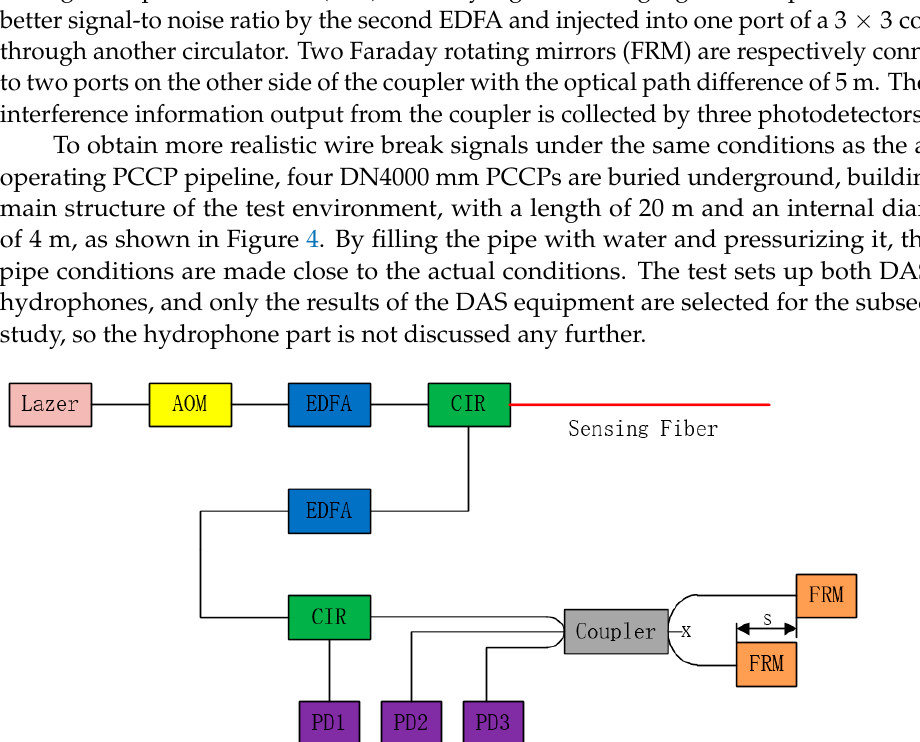
Figure 4. Sketch of the test setup. Prior to the test, seal panels are installed at both ends of the PCCP and customized cable entry seals are installed in the opening on the side walls of the manhole; a pressure- and water-resistant armored communication fiber-optic backbone cable is placed from the control room to the opening, and the armoring will attenuate the acoustic signal reaching the fiber core, thus reducing the signal-to-noise ratio. However, armoring is necessary to protect the fiber-optic cable; therefore, the armoring method must be iden- tical in all phases of the experiment to ensure that the signal can be accurately identified; then, polyurea is used to seal the gap between the fiber-optic cable and the entry device, adhering the sensing fiber-optic cable to the inner wall of the PCCP. We then splice the backbone fiber-optic cable and the acoustic fiber tail cable, splice the tail cable in the control room, and connect the DAS instrument; we close the discharge valve, seal the manhole, fill the pipe with water, and use a pressure pump to pressurize the pipe after filling it with water and keep the pressure stable. An electric pick and cutter are used to